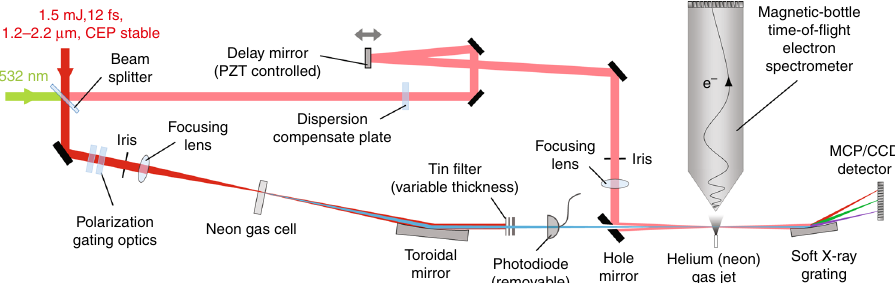
Fig. 1 Experimental set-up. Schematic illustration for isolated attosecond X-ray pulse generation and characterization. CCD charge-coupled device; MCP microchannel plate, PZT piezo-electric